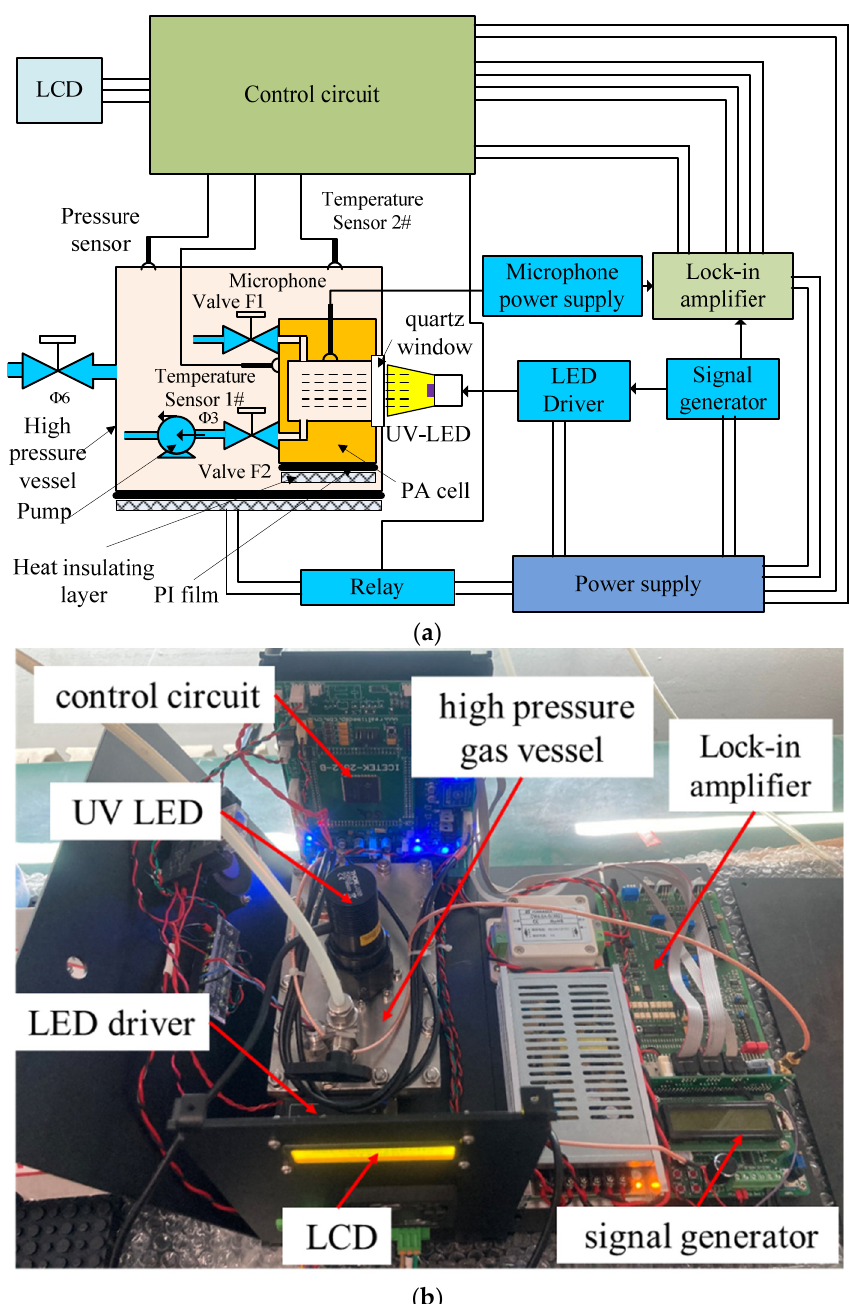
Figure 7. UV LED-based SO 2 detection system: ( a ) schematic diagram and ( b ) practicality picture.